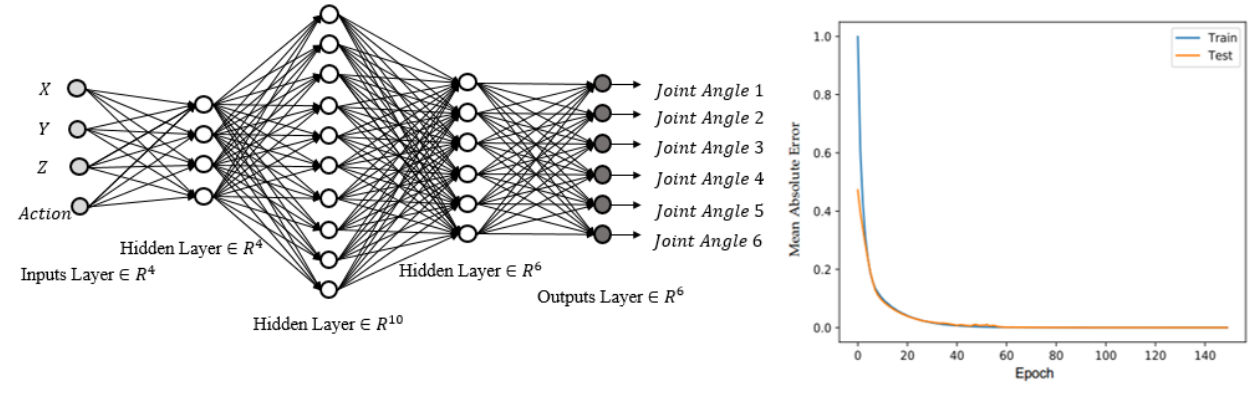
Figure 5. Structure of the second neural network and its mean absolute error